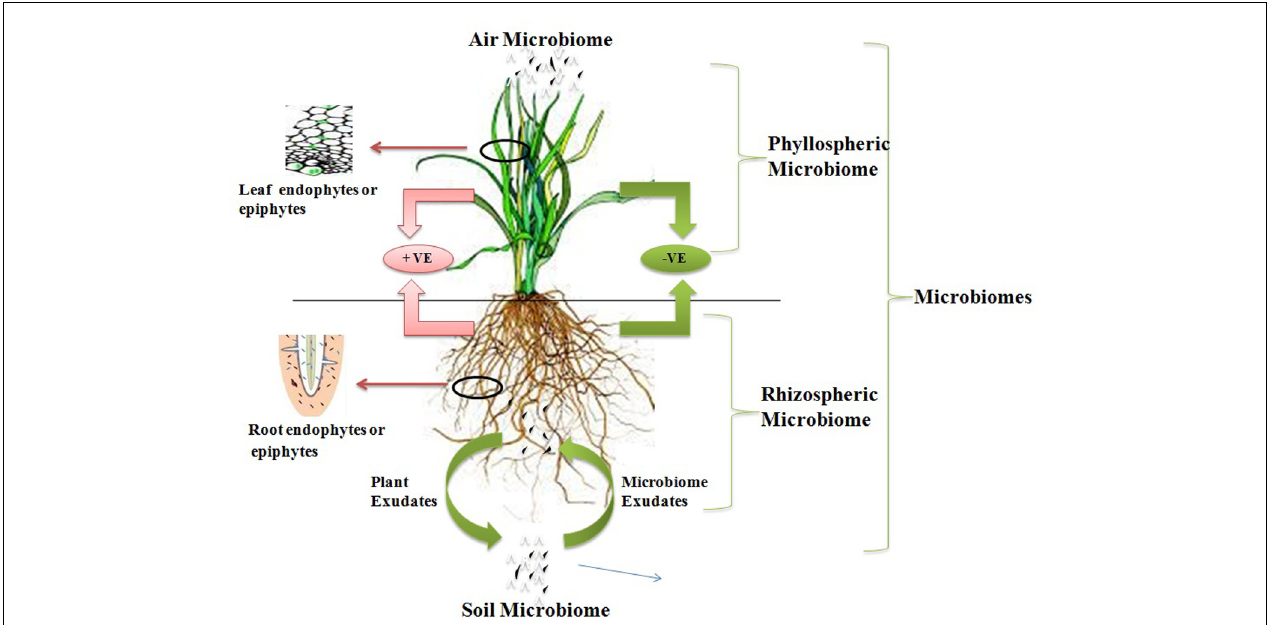
FIGURE 1 | Representation of plant–microbe interaction in different